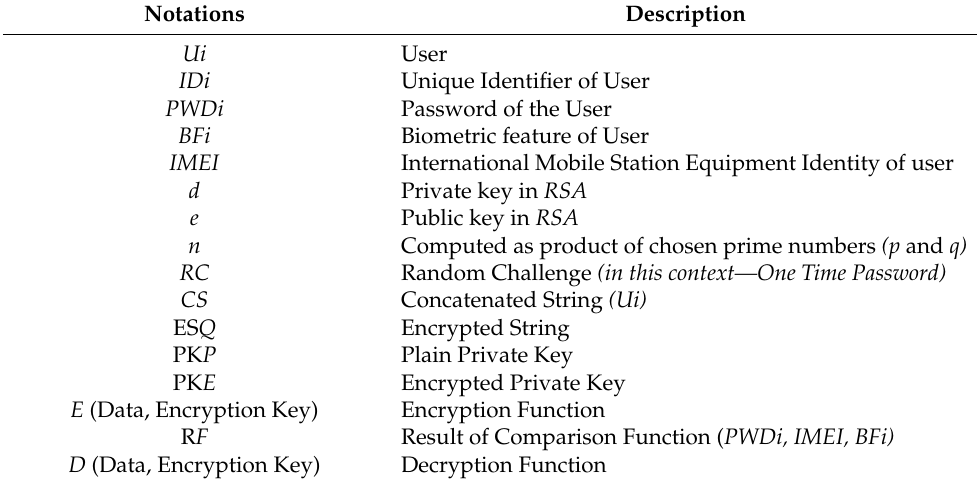
Table 2. List of the symbols used.